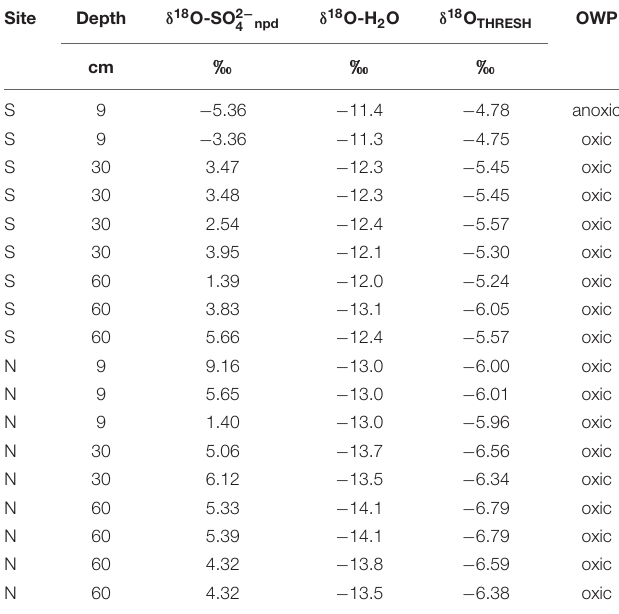
TABLE 6 | Oxygen isotopes of weathering-derived sulfate ( δ 18 O-SO 2 − 4 npd ) and water ( δ 18 O-H 2 O) compared to the threshold for anoxic oxidation of pyrite ( δ 18 O THRESH